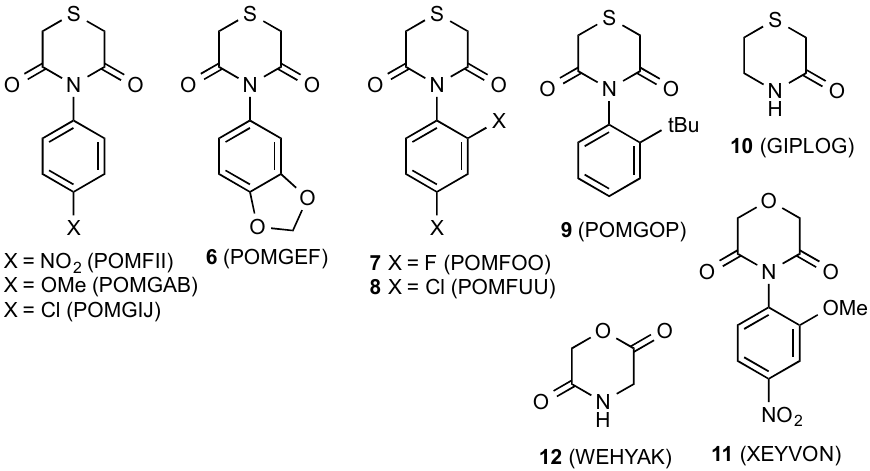
Figure 4. Similar structures characterized by X-ray diffraction with CCDC Ref Codes.